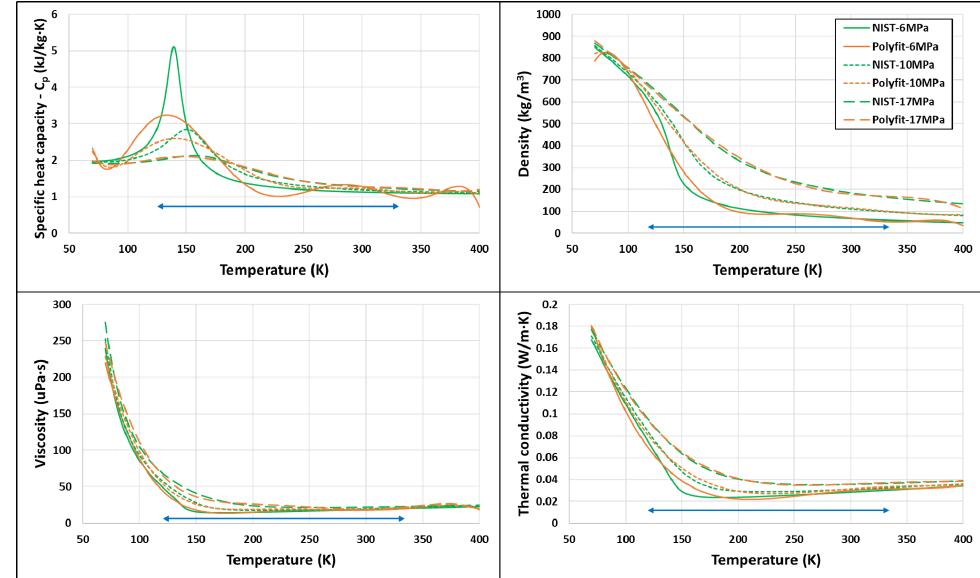
Figure 7. Polynomial fitting of NIST data for isobaric thermophysical properties of N 2 —specific heat capacity at constant pressure, density, viscosity and thermal conductivity at 6, 10 and 17 MPa. Adapted from